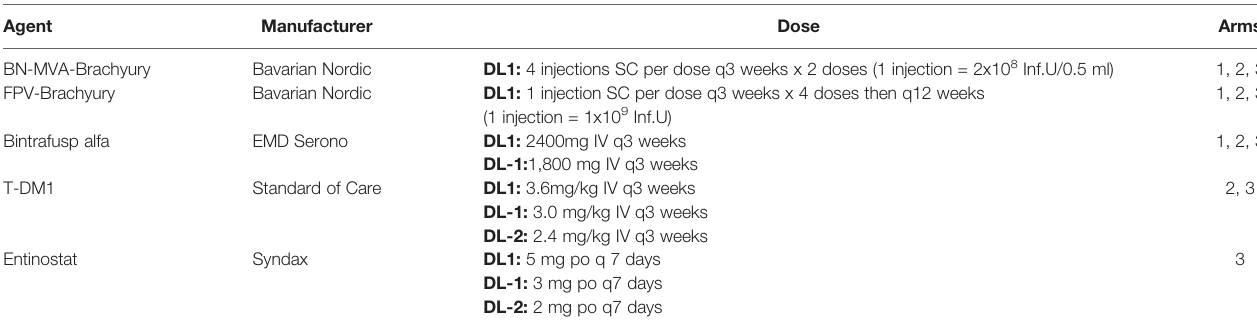
TABLE 1 | Trial agents and dosing